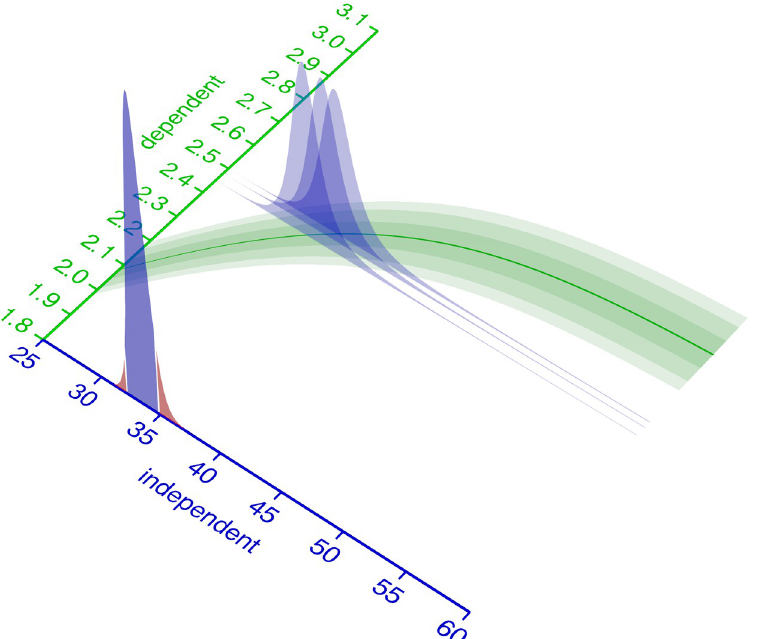
Fig 3. Diagnostic plots of model fits. The raw data (blue dots) and corresponding fit is visualized in the top row alongside 95, 90, and 68% likelihood bands of the model. Linear and logistic models were fitted to synthetic data to show three kinds of lack-of-fit error (columns 1–3) in comparison to a perfect fit (column 4). The underlying structure of the data and model is as follows: A : Homoscedastic linear model, fitted to homoscedastic nonlinear data. B : Homoscedastic linear model, fitted to heteroscedastic linear data. C : Homoscedastic linear model, fitted to homoscedastic linear data that is Lognormal-distributed. D : Heteroscedastic logistic model, fitted to heteroscedastic logistic data. The residual plots in the middle row show the distance between the data and the modeled location parameter (green line). The bottom row shows how many data points fall into the percentiles of the predicted probability distribution. Whereas the lack-of-fit cases exhibit systematic under- and over-occupancy of percentiles, only in the perfect fit case all percentiles are approximately equally occupied.